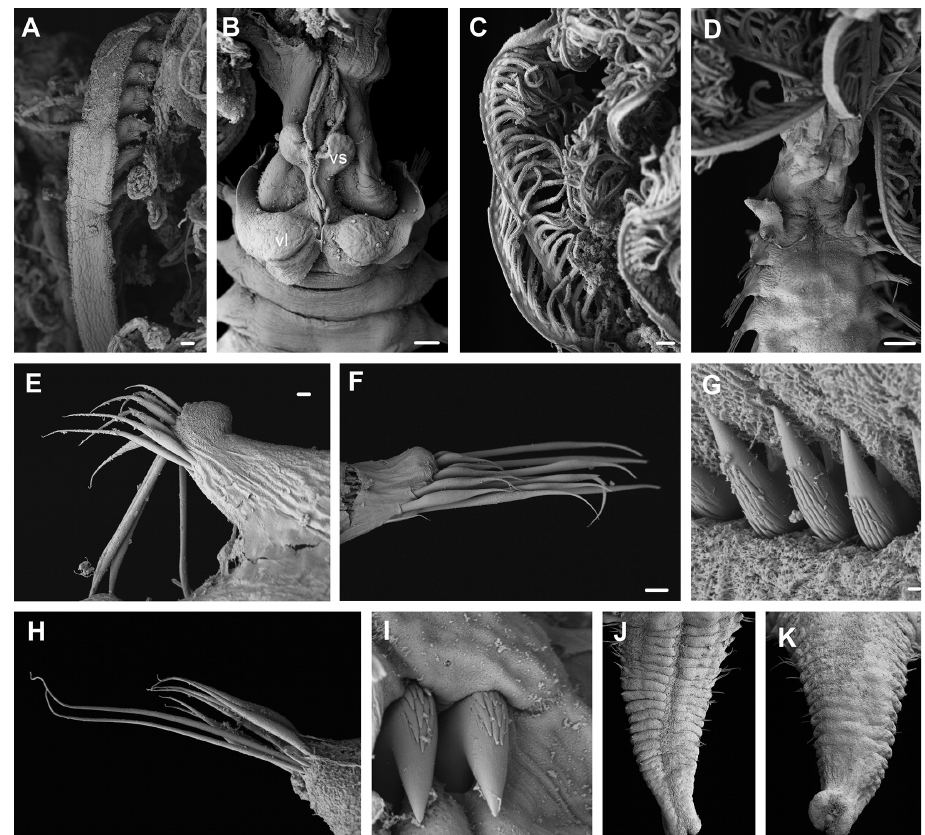
Figure 10. Pseudobranchiomma cf. P. schizogenica from Hawaii AM W.37206, AM W.37207: Scanning electron micrographs. A Detail of radiolar flanges serrations B Base of crown and anterior segments, ven- tral view C Lateral radioles D Anterior segments, dorsal view E Notopodia, first thoracic segment F No- topodia, second thoracic segment G Uncini, third thoracic segment H Neuropodia, posterior abdominal segment I Posterior abdominal uncini J Posterior end, ventral view (pygidium regenerating) K Posterior end, dorsal view. vl, ventral lappets; vs, ventral sac. Scale bars: A = 20 µm; B, C, J, K = 100 µm; D = 200 µm; E, H = 10 µm; F = 20 µm; G, I = 2